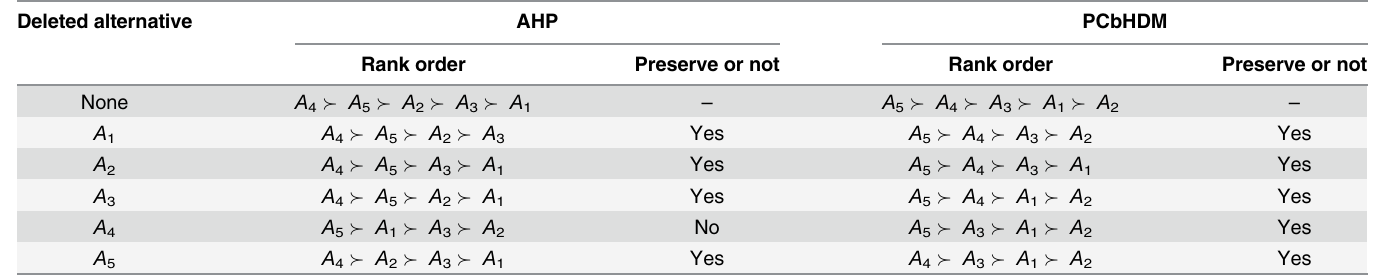
Table 6. Rank order with a single alternative deleted (consistent